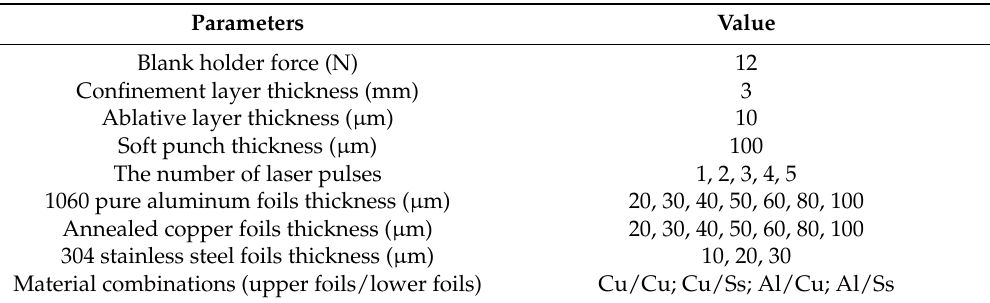
Table 3. The detailed experimental